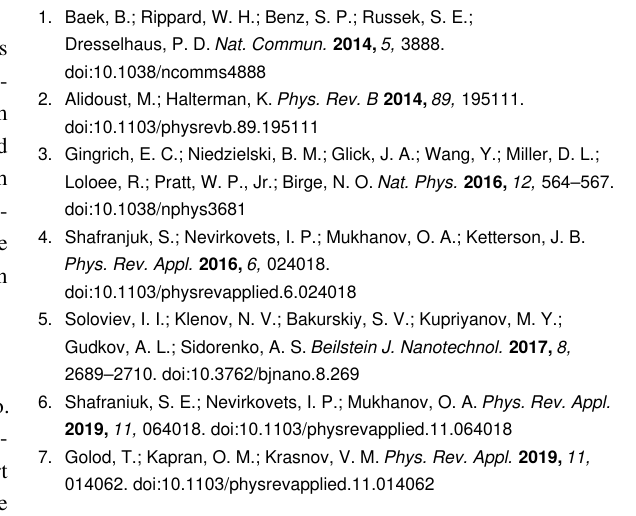
Taking into account more complex physical phenomena in the S/F multilayer structure, the future studies aim to increase the functionality of the proposed synapse. With a noncollinear mag- netization in the neighboring Co layers, the formation of a long triplet component in a supercurrent is possible in the consid- ered AFM [28-31]. This allows for a significant influence on the magnitude of the order parameter in superconducting layers, controlling the misorientation in the magnetization angles. The triplet superconducting correlations of electrons are formed from singlet correlations. Hence, this effect reduces the kinetic inductance of the s-layers in a quasi-monotonic manner with the magnitude of the controlling magnetic field. This effect